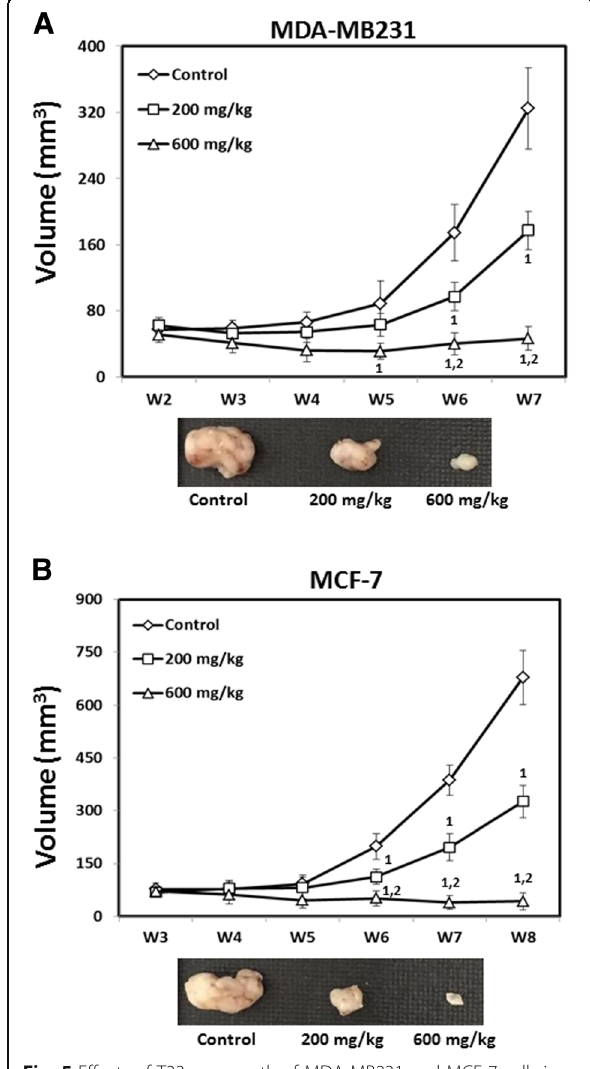
Fig. 5 Effects of T33 on growth of MDA-MB231 and MCF-7 cells in nude mice. After injection of a MDA-MB231 or b MCF-7 cells into second mammary fat pad of athymic BALB/c nude mice, the mice were administered 200 mg/kg and 600 mg/kg T33 daily, respectively, by oral gavage with PBS. Tumor volumes were measured weekly with a caliper and average weight of tumors from mice was analyzed. Representative images of retrieved xenograft tumors at endpoint are shown in the lower panel. The superscripts 1 and 2 refer to significant differences ( P < 0.05) from the control (0 mg/kg) and 200 mg/kg, respectively